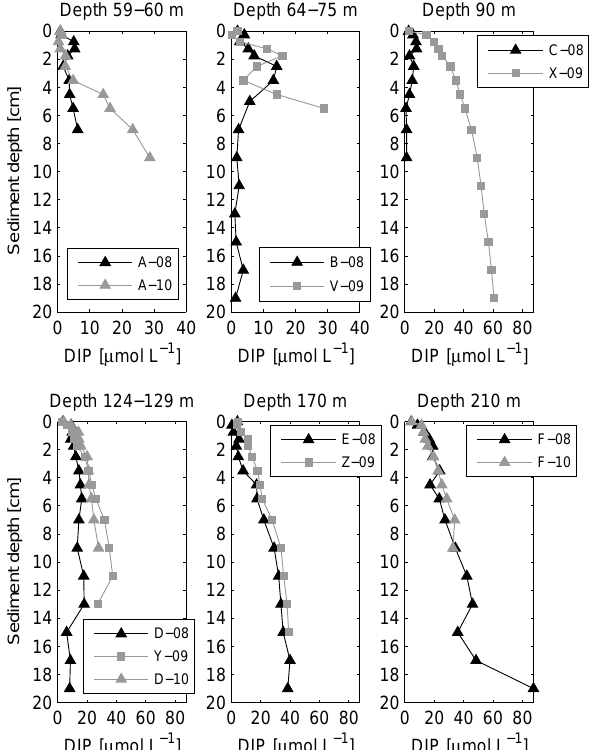
Fig. 3. Pore water DIP profiles at stations ≤ 90m (top three pan- els) and stations > 90m (bottom three panels) 2008–2010. Profiles Fig.3. PorewaterDIPprofilesatstations 6 90m(topthreepanels)andstations > 90m(bottomthreepanels)2008-2010. Profilesfrom stationsatsimilarbottomdepthsareshowntogether.Notethedifferentscalesonthex-axis. from stations at similar bottom depths are shown together. Note the different scales on the